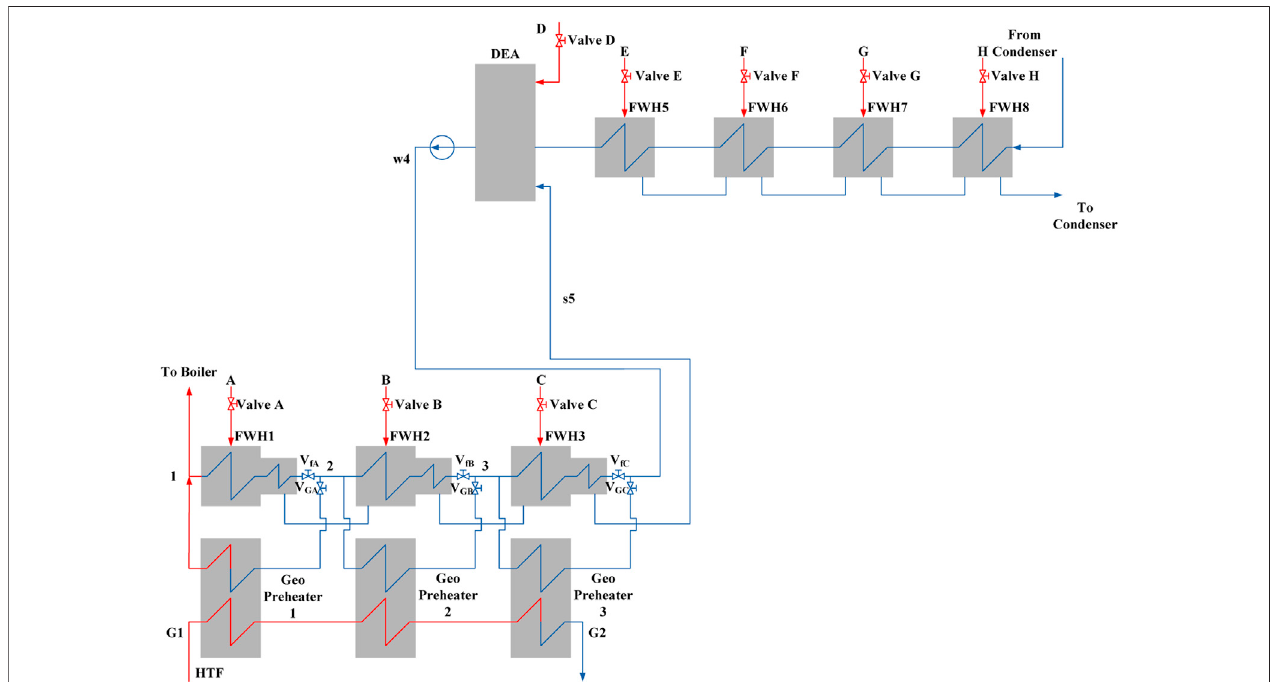
FIGURE 2 | Schematic diagram of parallel GAPG plant feedwater heater system.